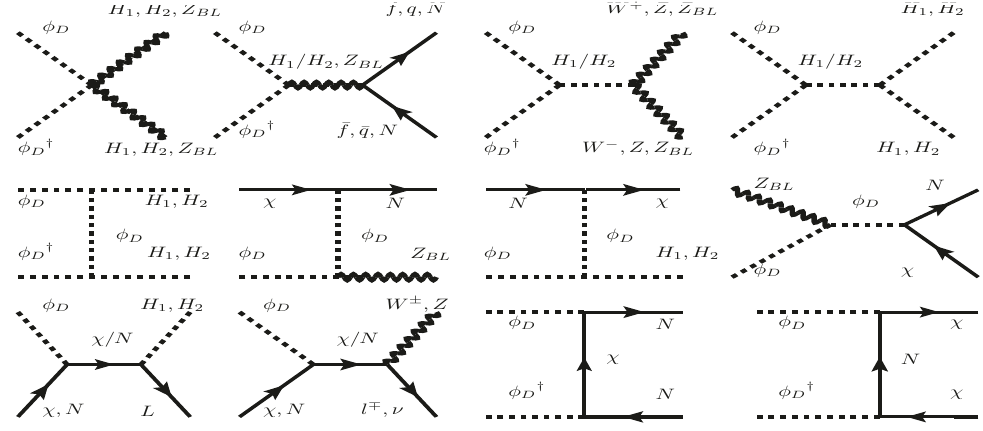
Figure 2 . Annihilation/scattering channels of φ D